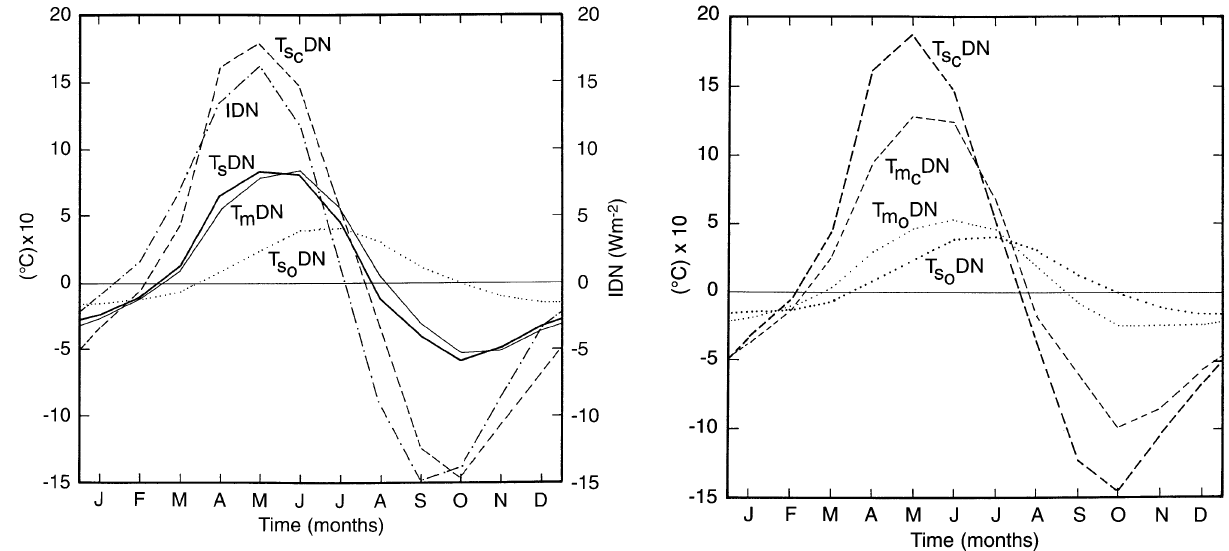
Fig. 7. Average over continents ( thin dashed line ) and over oceans ( thin dotted line ) of the mean tropospheric temperature anomalies; and average anomalies of continental ground temperature ( thick dashed line ) and ocean surface temperature ( thick dotted line